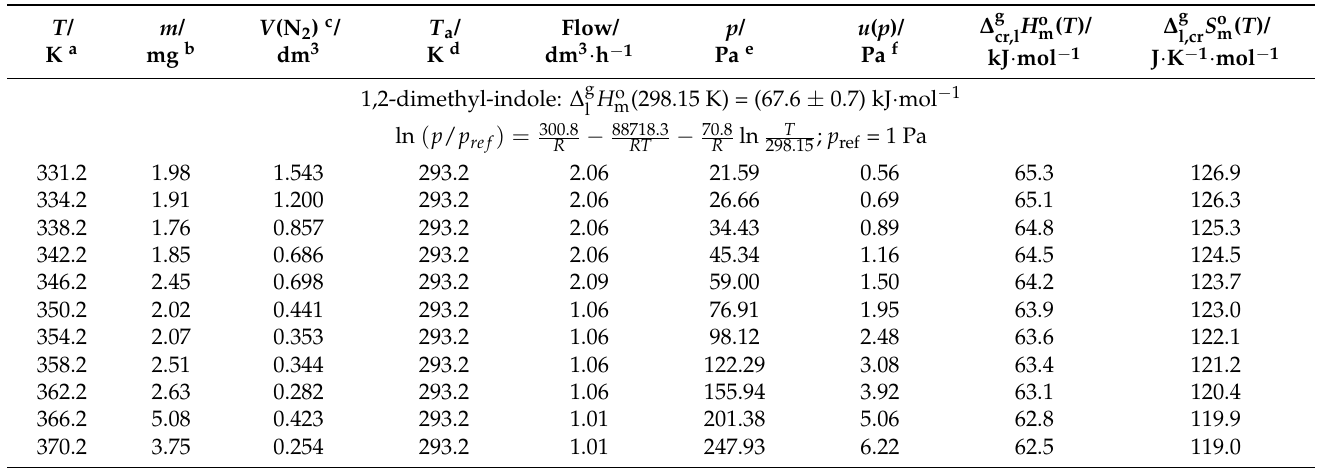
H o m of methyl- cr,l